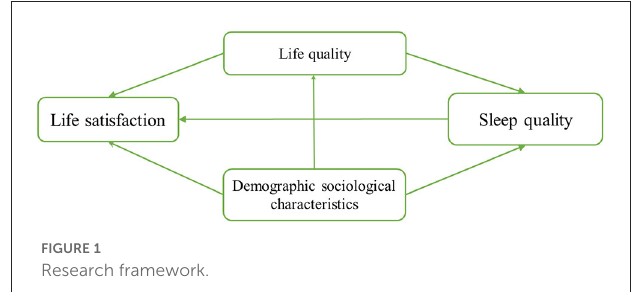
FIGURE1 Research